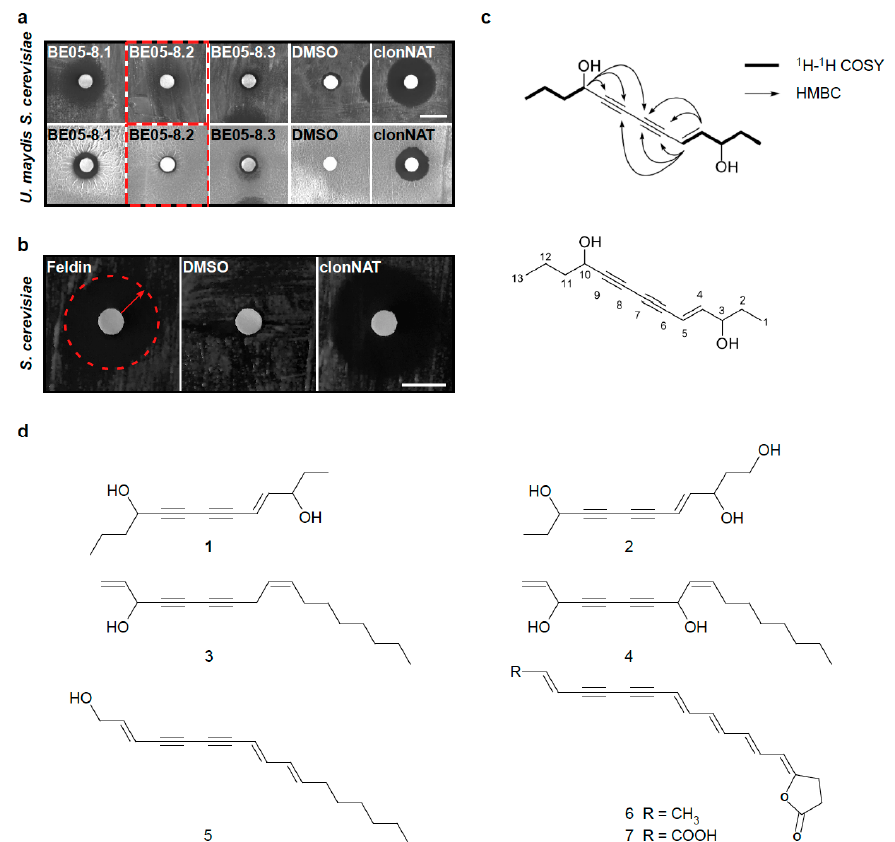
Figure 3. Bioactivity-guided fractionation from the basidiomycete ethyl acetate crude extract BE05; bioactivity of the freshly isolated bioactive compound against S. cerevisiae , and structure analysis of this compound (feldin). ( a ) Bioactivity test of fraction 8.2 (highlighted by a dashed frame) and two adjacent fractions from basidiomycete ethyl acetate crude extract BE05 against S. cerevisiae and U. maydis . The biotesting with fraction 8.2 yielded a zone of growth inhibition with S. cerevisiae (halo), while resulting in minimal growth inhibition with U. maydis . In total, 100 µg of this fraction were dissolved in DMSO to impregnate the filter paper disk. DMSO was used instead of the extract as negative control and 200 µg of clonNAT dissolved in ddH 2 O was used as positive control, respectively. The scale bar represents 1 cm. Three independent biological experiments (n = 3) were carried out. ( b ) Bioactivity test against S. cerevisiae of a subsample of the F. hepatica polyyne feldin, which was directly saved from fraction 8.2.6 before running NMR. The biotesting with extract BE05 from the top left panel yielded a zone of growth inhibition (halo, dashed red circle with arrow) with S. cerevisiae . Here, 100 µg of feldin was dissolved in DMSO to impregnate the filter paper disk. DMSO was used instead of the extract as negative control and 200 µg of clonNAT dissolved in ddH 2 O was used as positive control, respectively. The scale bar represents 1 cm. Three independent biological experiments (n = 3) were carried out. ( c ) Structure of the F. hepatica polyyne feldin. ( d ) Similarity of chemical structure of feldin with known polyynes (1 in bold face, feldin; 2, 4-dodecene-6,8-diyne-1,3,10-triol; 3, falcarinol; 4, falcarindiol; 5, oenanthetol; 6, xerulin; 7, xerulinic acid).